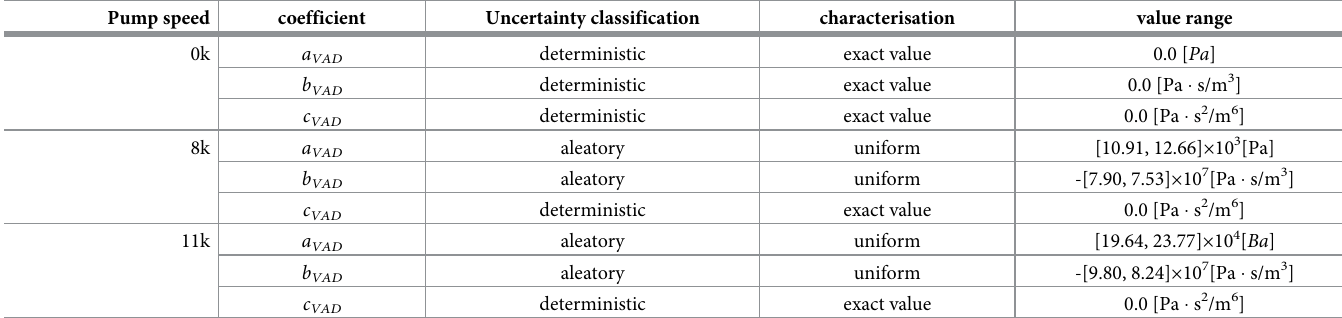
Table 6. Range of H-Q curve coefficients used for the UQ analysis. The range is obtained as 2 � num + � fit where � fit is 10% of the measured value. Pump